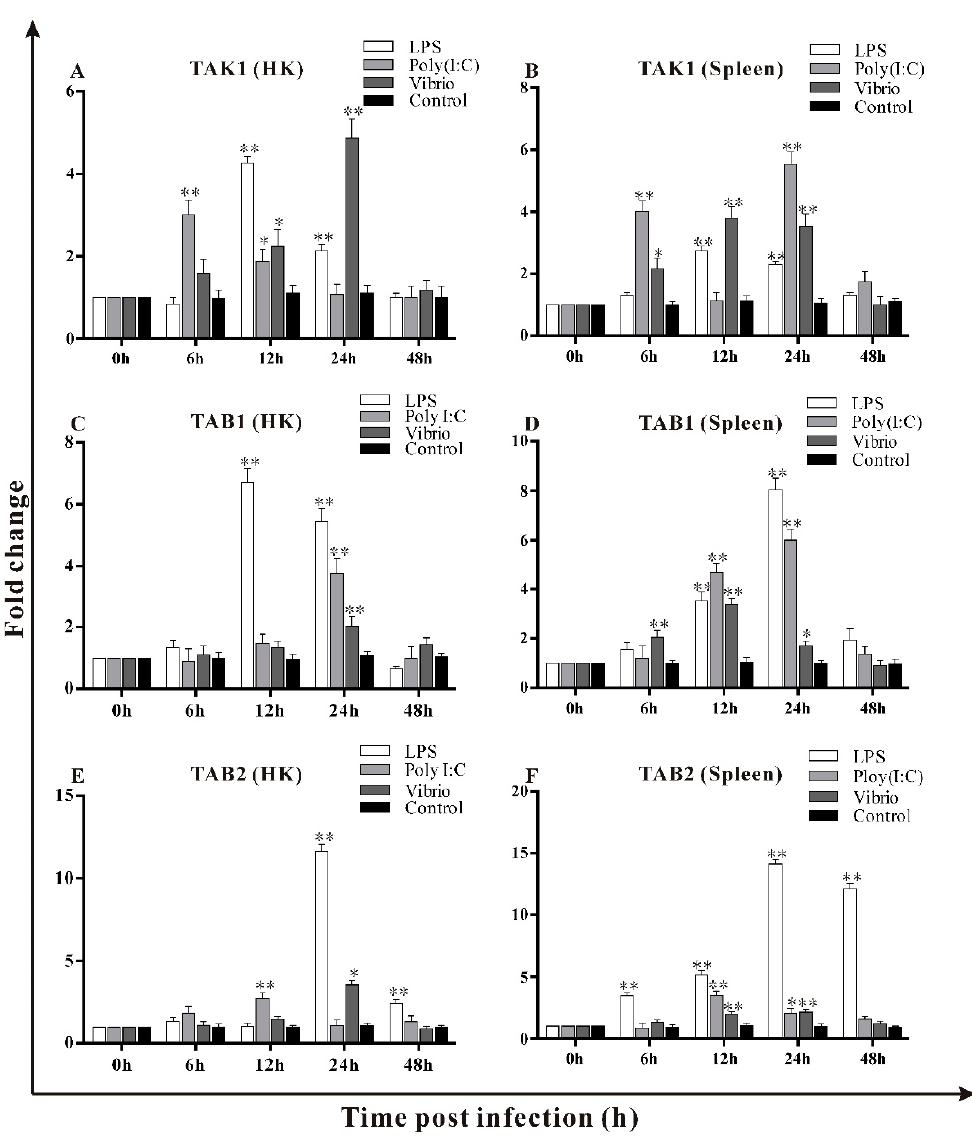
Figure 9. Expression patterns of trTAK1, trTAB1 and trTAB2 in spleen and head kidney (HK) following the Vibrio alginolyticus , LPS and poly I:C challenge ( A – F ). The expression changes of the three genes were analyzed using the 2 △△ CT method. The relative expressions of target genes in each tissue were normalized to that of β -actin and fold-change relative to the expression levels at time 0 (set as 1). Results are expressed as mean ± SE from three independent triplicated experiments. Asterisks and double stars indicate that the same experimental group is significantly different from 0 h (* p < 0.05, ** p <